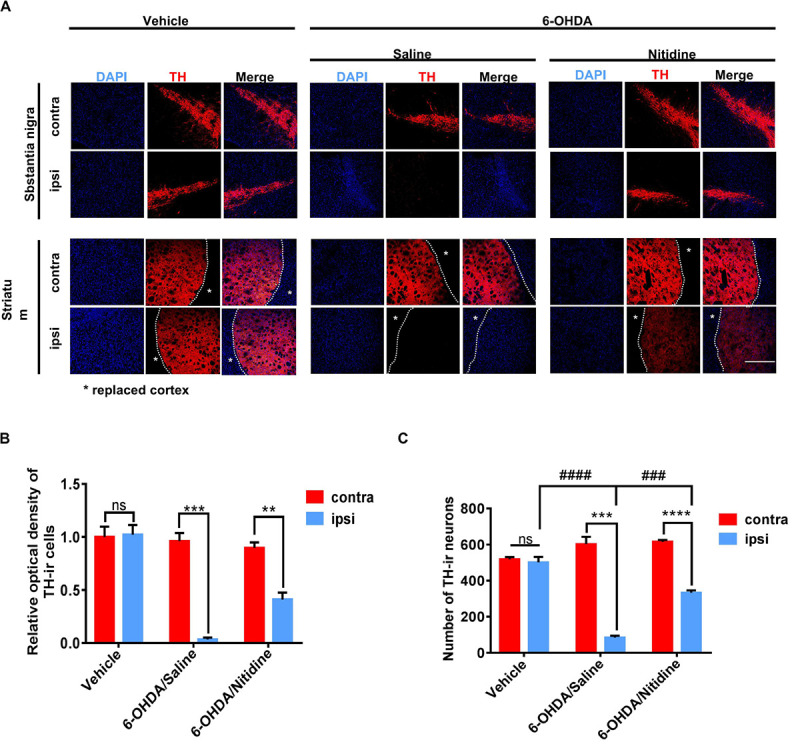
Dopaminergic neuron survival in Parkinson’s disease (PD) models following treatments. (A) Tyrosine hydroxylase (TH)-immunoreactive neurons (red) in the PD rats. Scale bar depicts 500 μm. (B) Statistical result of optical density values of TH-ir cells in SN (t-test). Vehicle group: P = 0.8816, t = 0.1587, df = 4, F = 1.144. 6-Hydroxydopamine (6-OHDA)/saline: P = 0.0003, t = 11.86, df = 4, F = 18.13. 6-OHDA/nitidine: P = 0.0043, t = 5.853, df = 4, F = 1.571. (C) Statistical result of TH-ir cell numbers in SN (t-test). Vehicle group: P = 0.6134, t = 0.5472, df = 4, F = 6.356. 6-OHDA/saline: P = 0.0002, t = 12.47 df = 4, F = 14.23. 6-OHDA/nitidine: P < 0.0001, t = 17.85, df = 4, F = 1.652. Comparison between ipsilateral sides: one-way ANOVA. P < 0.0001, F = 113.8. *Comparison between contralateral and ipsilateral from a single group. #Comparison between different groups. ns P > 0.05, #P < 0.05, ####P < 0.0001, **P < 0.01, ***P < 0.001, ****P < 0.0001.